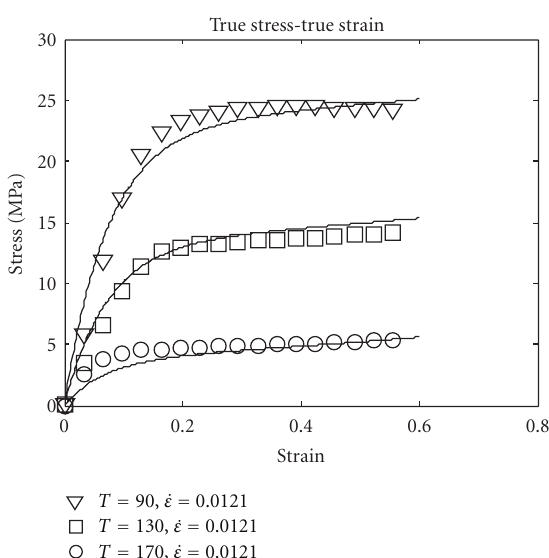
Figure 7: Comparison of simulation results with experimental data at strain rate